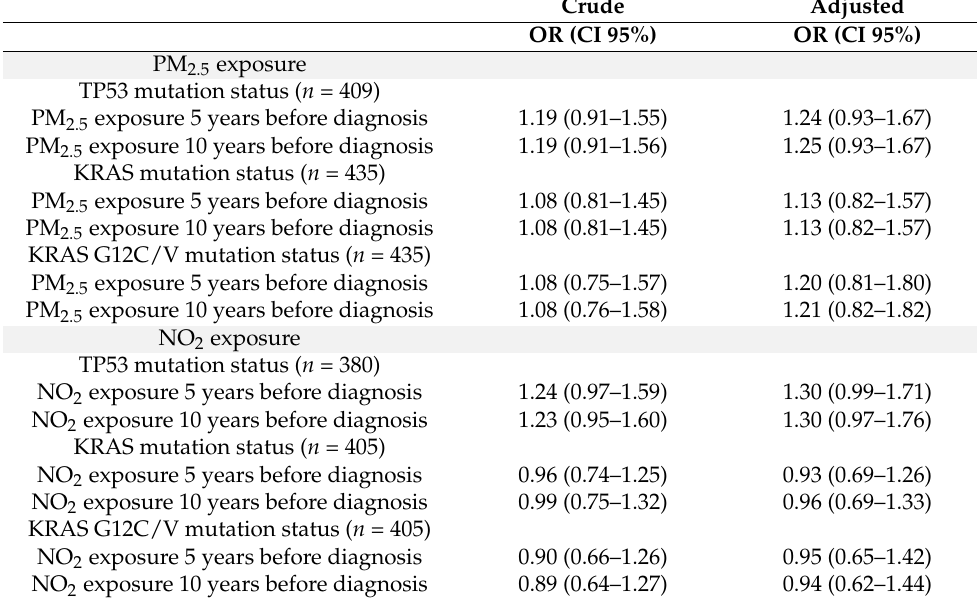
Table 3. Association between PM 2.5 and NO 2 concentrations 5 and 10 years before cancer diagnosis and lung cancer tumor